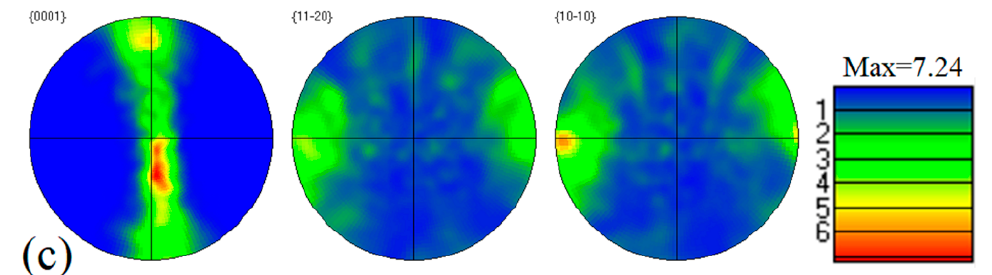
Figure 7. Pole figures of as-extruded Mg-Sn alloys obtained by EBSD (along the extrusion direction): ( a ) Mg-6Sn; ( b ) Mg-6Sn-2Zn; and ( c ) Mg-6Sn-2Zn-1Ca.